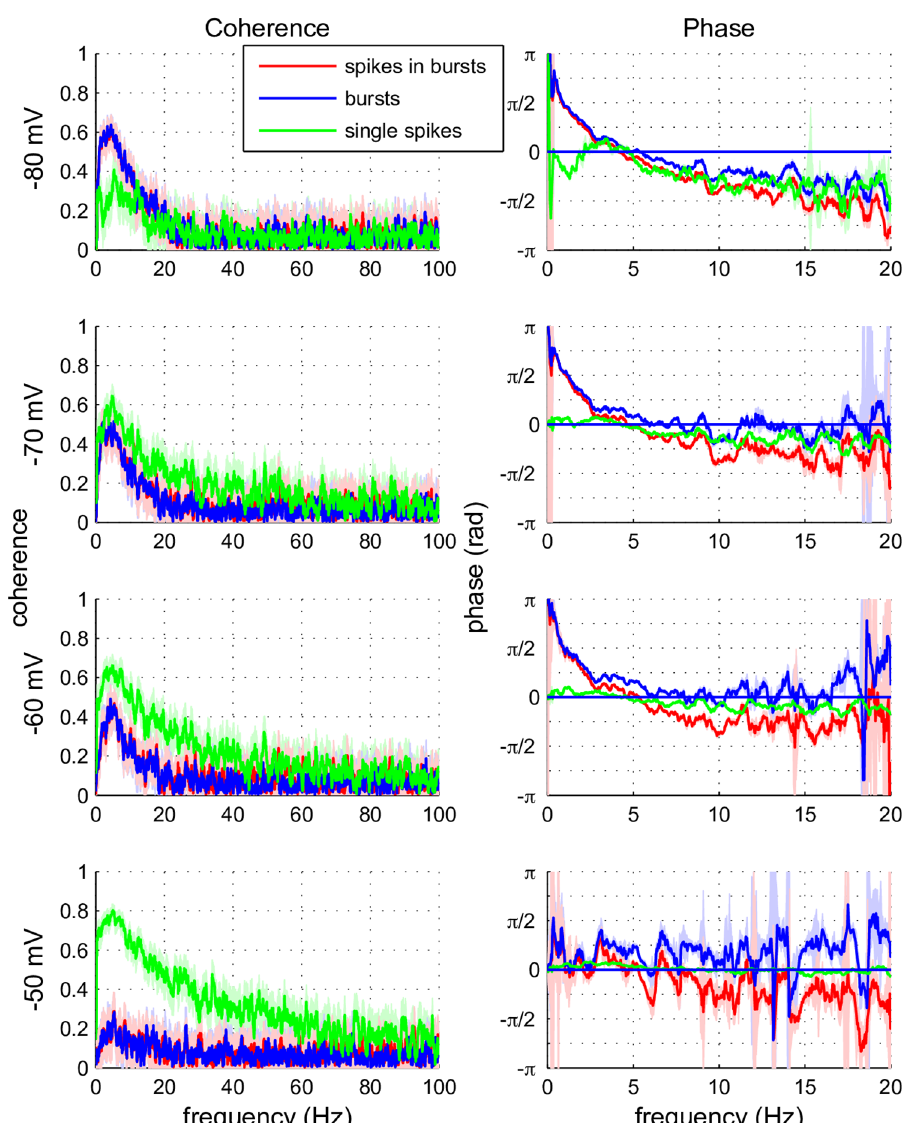
Fig 4. Coherence and phase between input current and spikes or bursts. Coherence (left column) and phase (right column) between the input current and the timing of three different activity components in the TCR cells: bursts, spikes and ‘follower’ spikes in bursts. Calculations were performed over the first 500 s of each trial and for the four different membrane states. Coherence decreases for higher frequencies. Bursts (blue traces) phase-lock mainly to low frequencies, with positive phase (upstroke). Isolated spikes (green traces) show more broadband phase locking. Spikes in a burst (red traces) seem to follow the properties of the burst to which they belong. The colour shade around a trace indicates the confidence interval (95%) based on a jackknife